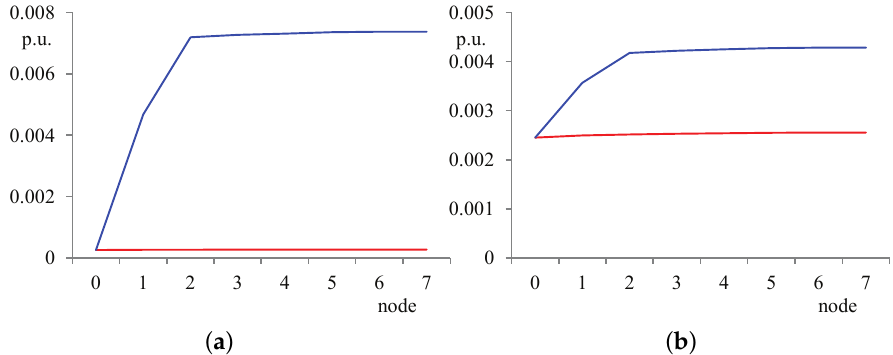
Figure 9. Voltage variations in the case of P DER (red) and feeder 2